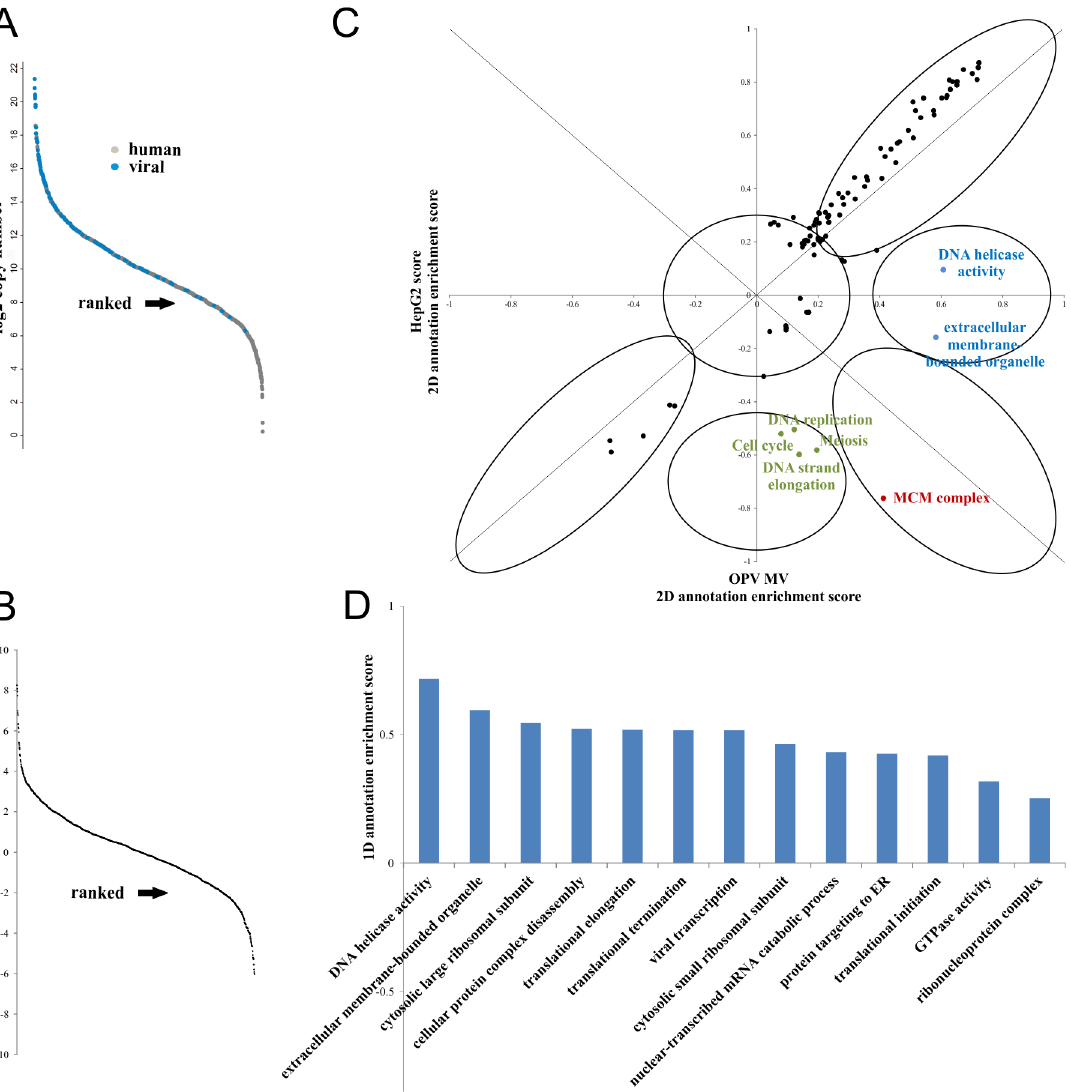
Fig 4. Analysis of putative OPV mature virion-associated cellular proteins. The distribution of the protein copy numbers of viral and human proteins is shown in A. In order to discriminate between putative MV-associated human proteins and contaminants, the protein abundances within the MV preparations and the abundances in HepG2 cells were used for 1D and 2D annotation enrichment analysis. For the 2D analysis, normalized iBAQ values of the OPV MV and HepG2 cells were used. The score distribution of enriched GO terms with a FDR below 0.01 is plotted in C. Terms along the diagonal (black) are enriched or depleted in the MV and the cells in the same way and represent cellular background. The GO terms on the right side of the diagonal are enriched in the MV relative to the cell, and therefore represent putative MV-associated human proteins. If the proteins behind the GO terms are associated with increasing abundance in the OPV MV the terms are labelled blue, if they are associated with increasing abundance in the MV and associated with low abundance in the cells the terms are labelled red and if they are associated with low abundance in the cells the terms are labelled green. For 1D annotation enrichment analysis, iBAQ ratios for the human proteins in the MV preparations relative to the abundance in HepG2 cells were calculated (B). The score distribution of GO terms enriched in the MV preparations with a FDR below 0.01 is shown in D, redundant terms were removed from the Fig but can be found in Table L in S1